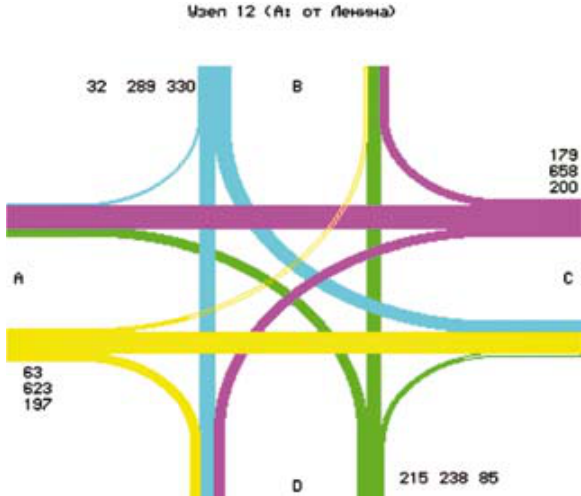
fig. 7. Cartogram of traffic volume